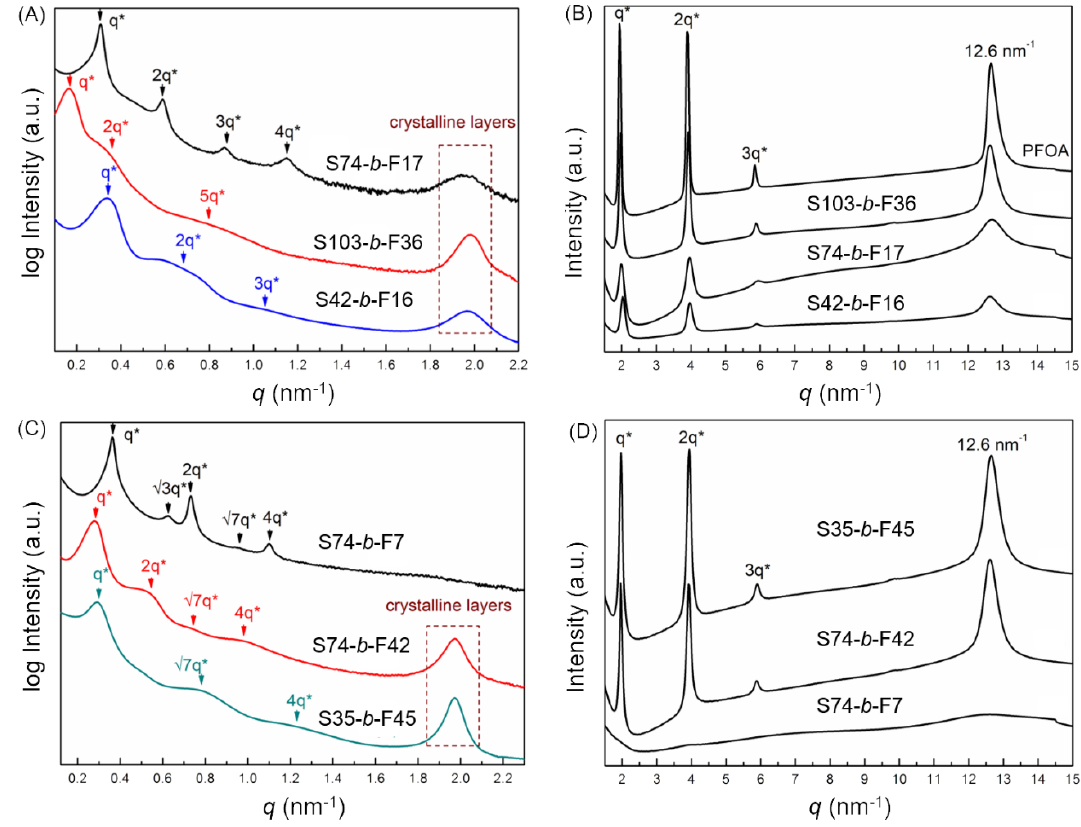
Figure 2. Small-angle X-ray scattering (SAXS) curves of S- b -F samples showing ( A ) lamellar and ( C ) hexagonal morphology. Layered crystalline PFOA structures could be identified in wide-angle region ( B , D ).